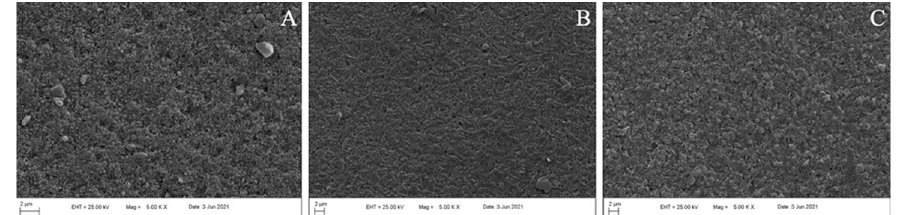
Figure 5. SEM images of tested materials after 5% hydrofluoric acid etching: ( A ) NLD; ( B ) LDS; ( C ) ZLS.